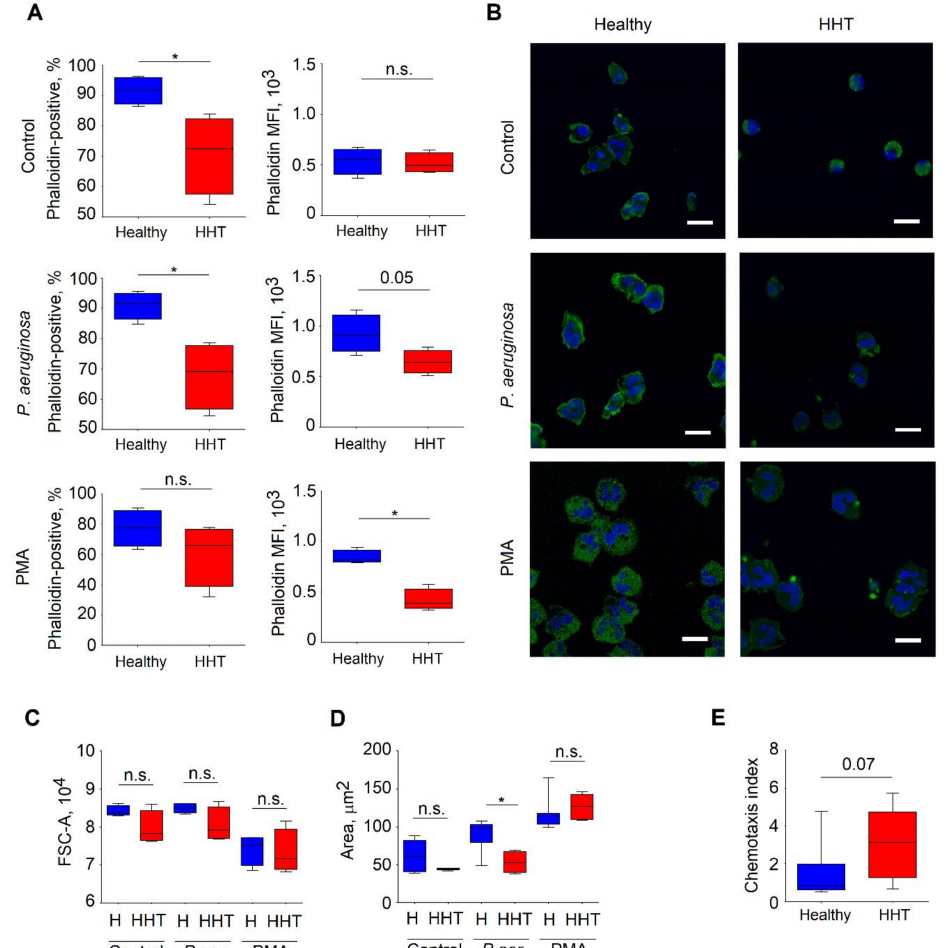
Figure 5. Altered actin cytoskeleton in HHT patients. ( A ) The percentage of phalloidin-stained neutrophils and mean fluorescence intensity (MFI) under di ff erent conditions (control, PMA and P. aeruginosa ) was lower in HHT in comparison to healthy individuals. ( B ) Representative pictures illustrating altered actin cytoskeleton of neutrophils in HHT patients after stimulation with PMA or P. aeruginosa , DAPI in blue, F-actin (phalloidin) in green, scale bar: 10 µ m. ( C ) No di ff erence in cell size (proportional to FSC value) of neutrophils in suspension was observed between HHT and healthy groups. Comparison of the mean value of FSC of the neutrophils. ( D ) Smaller area of adherence of the neutrophils in HHT versus the healthy group after stimulation with P. aeruginosa . ( E ) Neutrophils in HHT in comparison to healthy probands had a tendency of better migratory capacity towards lipopolysaccharide. Data are presented as median (25–75 percentiles); Mann–Whitney U test was used to compare groups, * p < 0.05. Healthy: n = 7, HHT: n = 9, HHT = hereditary hemorrhagic telangiectasia, MFI = mean fluorescence intensity, FITC = fluorescein, P. aeruginosa = Pseudomonas aeruginosa , PMA = phorbol-12-myristat-13-acetat, DAPI = 4 (cid:48) ,6-diamidin-2-phenylindol, FSC = forward scatter, n = number of